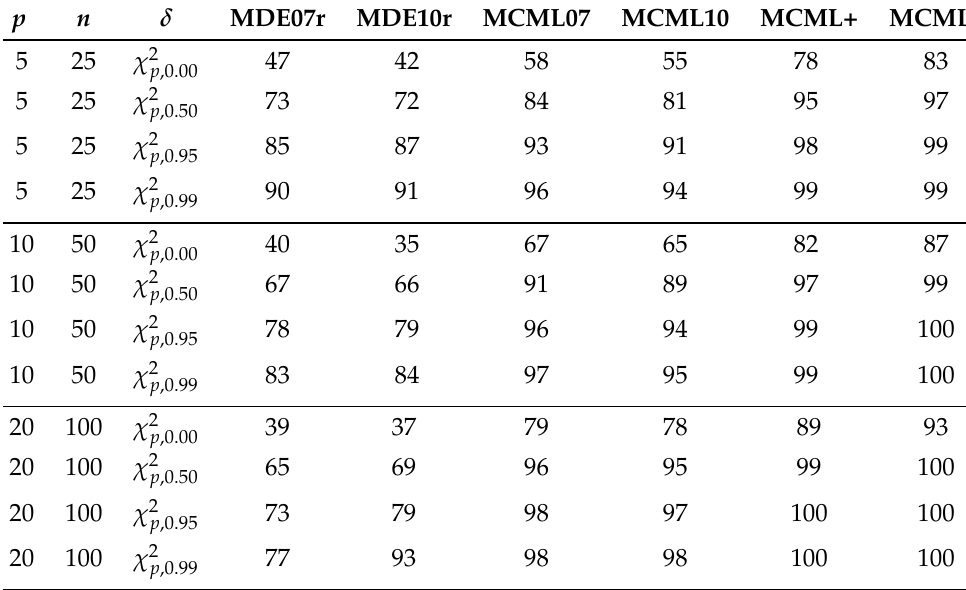
Table 3. Monte Carlo efficiencies (%) of the MDE and MCML estimators of the Poisson regression